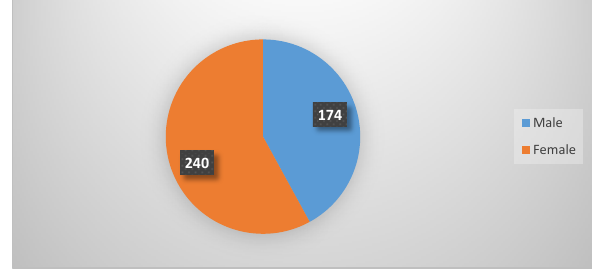
Figure 7. Distribution of respondents by gender The respondents were asked how old they were, and hence into what age range they belonged. This question was asked to ensure the respondents were in youth voter group. Figure 8 depicts the respondents‟ ages.